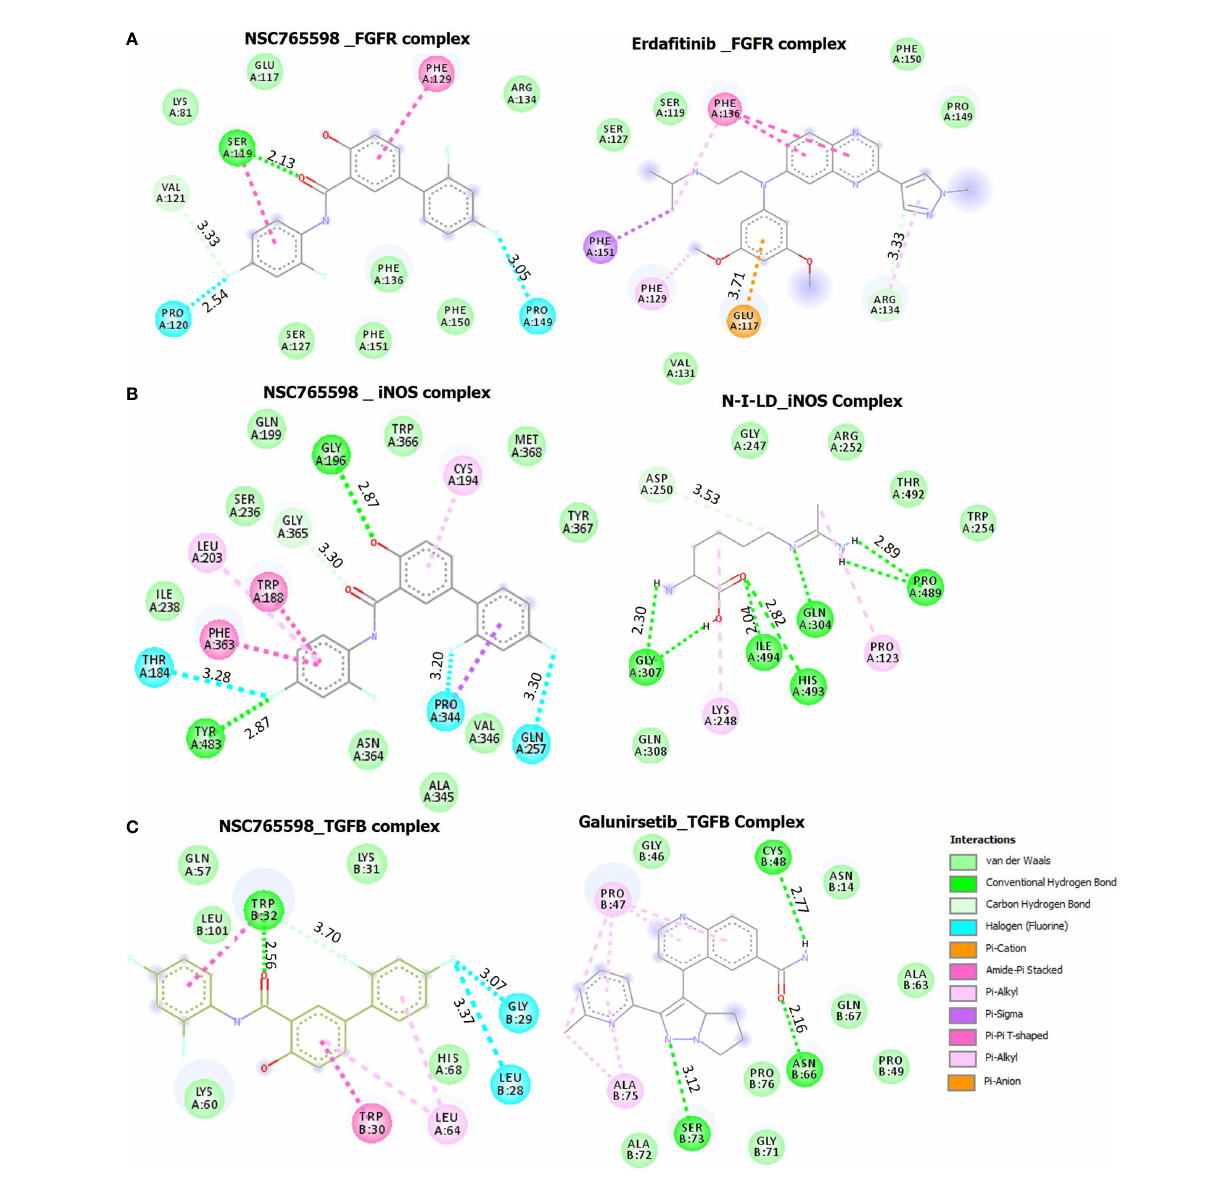
FIGURE 8 | Docking pro fi les of iNOS/FGFR/TGFB with NSC765598 and standard inhibitors. The two-dimensional (2D) representations of ligand – receptor complexes, showing the interacting amino acid residues and the type of interactions, occurring between the ligands and (A) iNOS (B) FGFR and (C)